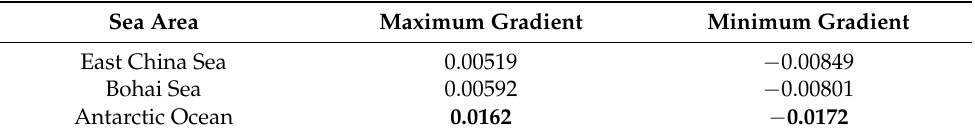
Table 1. The maximum and minimum gradient of the local areas. The numbers in bold in the table are the values with the largest absolute values in the comparison, which both come from the Antarctic